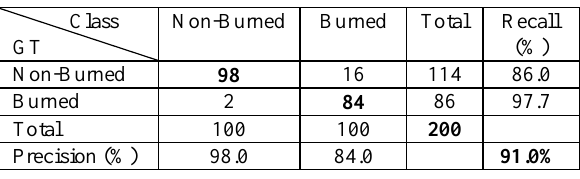
Table 6 . Confusion Matrix of ground truth (GT) and classification (Class) for the use case example in Central Africa using the global model. The bottom right cell displays the overall accuracy. The F 1 -score for non-burned is 91.6% and for burned 90.3%.